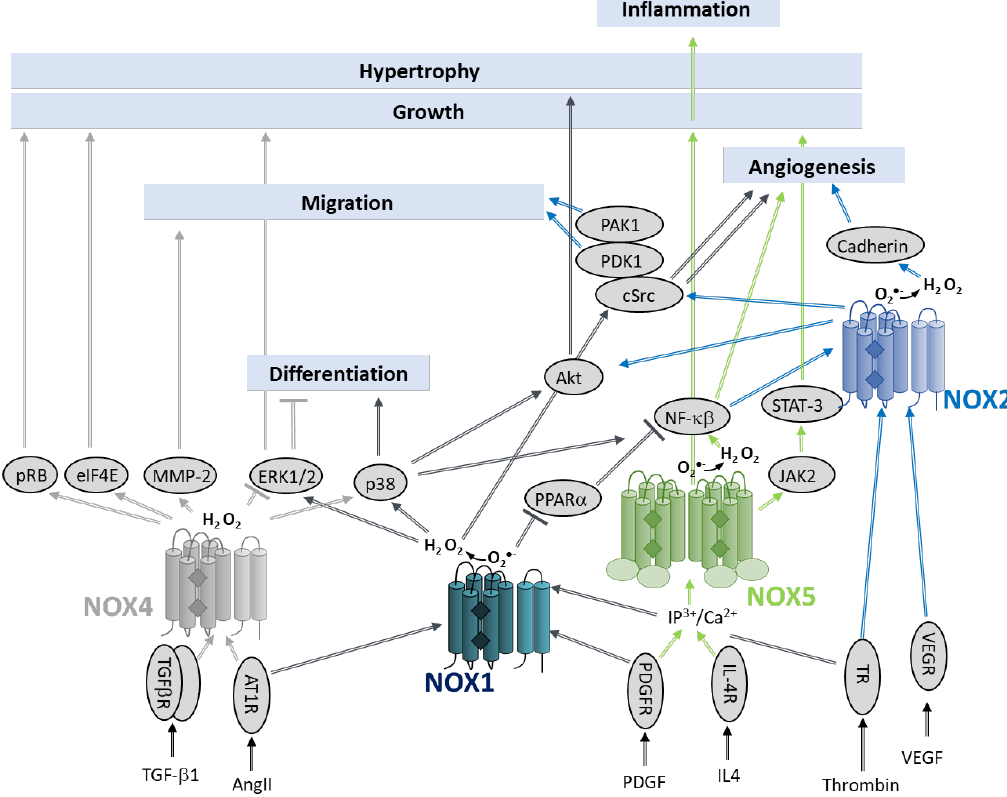
Figure 22. Examples of signaling pathways involving NOX1, 2, 4 and 5 in the regulation of the different tumorous stages. NOX1-derived superoxide, activated by thrombin, PDGF or Ang II, can affect cell differentiation via the p38 and ERK1/2 pathways, hypertrophy via p38-mediated Akt activation, cell migration via cSrc (Proto-oncogene tyrosine-protein kinase Src) activation and cell growth via ERK1/2 activation, subsequent activation of transcription factor Ets-1 and upregulation of cyclin D. NOX1 also downregulates the expression and activity of the antiangiogenic receptor PPARα, which is known to inhibit the NF-κB transcription factor and thus angiogenesis. NOX2, activated by TNFα, thrombin or NF-κB-induced ROS, promotes migration and angiogenesis via the Akt and cSrc pathways. NOX2-mediated regulation of angiogenesis also occurs via cadherin, p38 activation or regulation of ERK1/2 activation mediated by NOX4-derived H 2 O 2 . NOX2 also regulates cell growth via p38 activation or inhibition of ERK1/2 differentiation, and migration via the eiF4E (Eukaryotic translation initiation factor 4E) and pRB pathway. NOX4 expression and activity are promoted by TGF-β1 or Ang II. NOX5, whose superoxide production is activated by IL4 or PDGF, promotes cell growth and inflammation, respectively, through the JAK-2 / STAT3 and NF-κB signaling pathways. Inspired by [385].